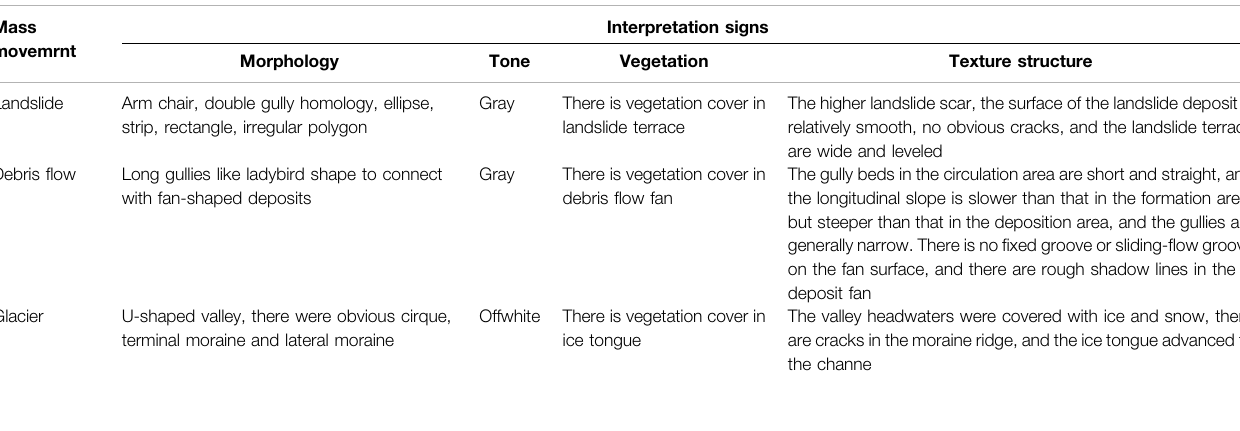
TABLE 1 | Remote sensing interpretation signs of different mass